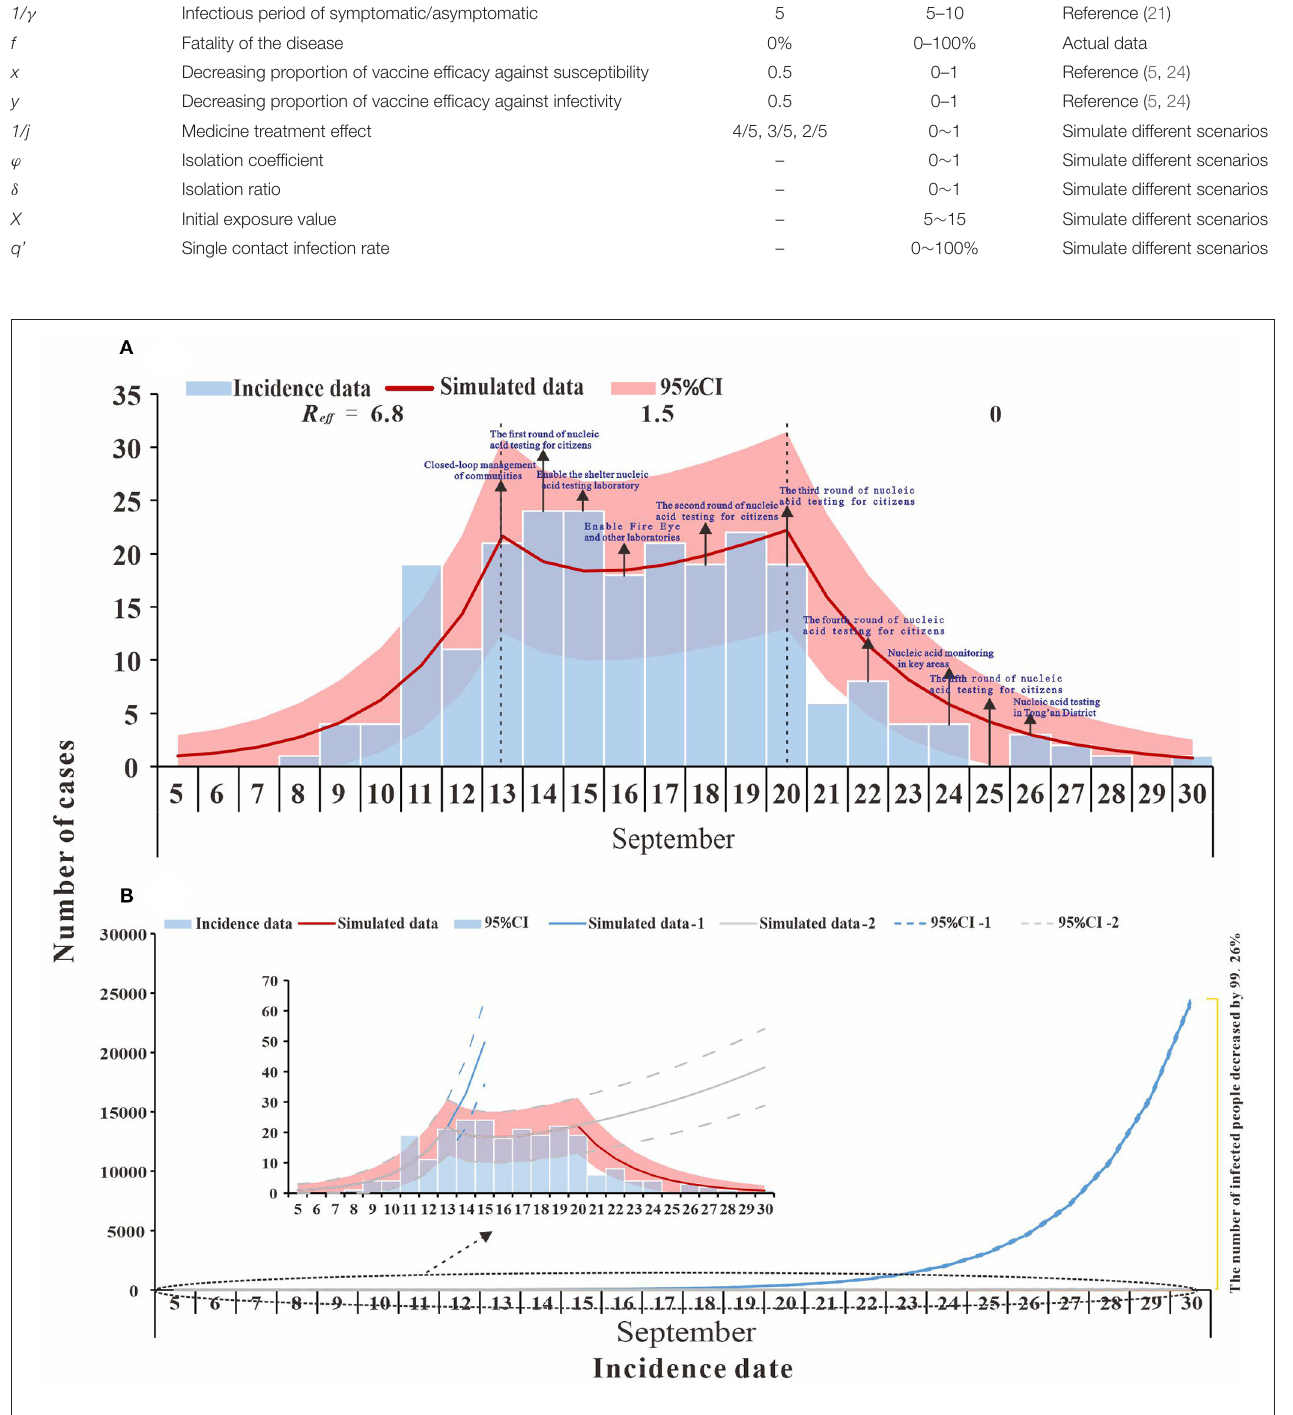
Frontiers in Public Health |